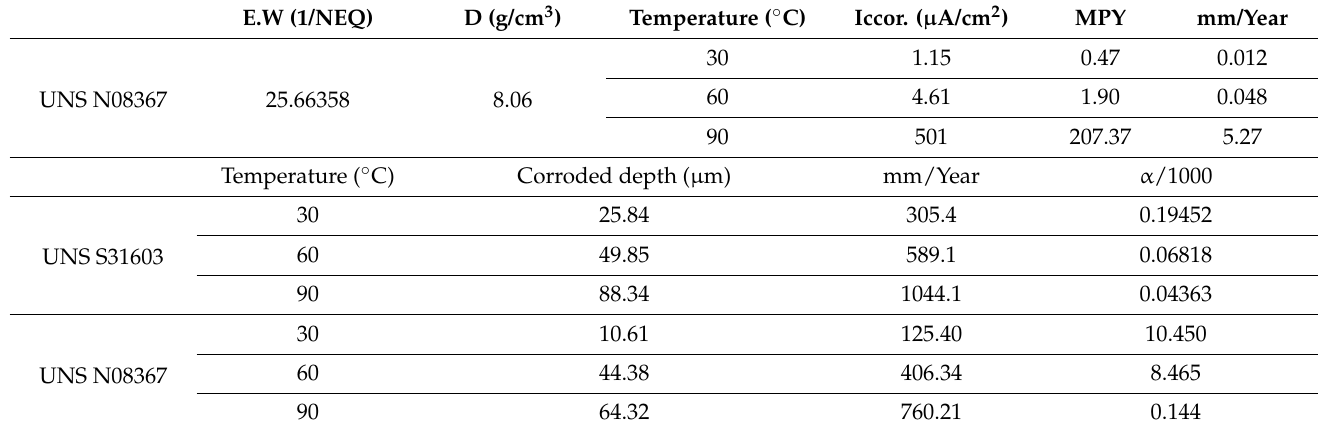
Table 3. Alpha( α ) value calculation process after the electrochemical experiments on UNS S31603 and UNS N08367 in a modified green death solution with temperatures.